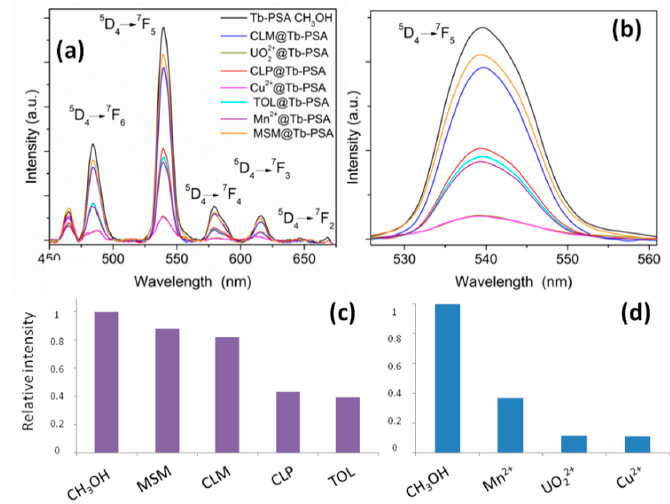
Figure 7. ( a )Emission spectra of Tb-PSA under exposition to different pollutants (concentration = 2 × 10 − 3 M). ( b ) Zoomed region of the Tb 3+ hypersensitive 5 D 4 → 7 F 5 transition. Relative intensities of the